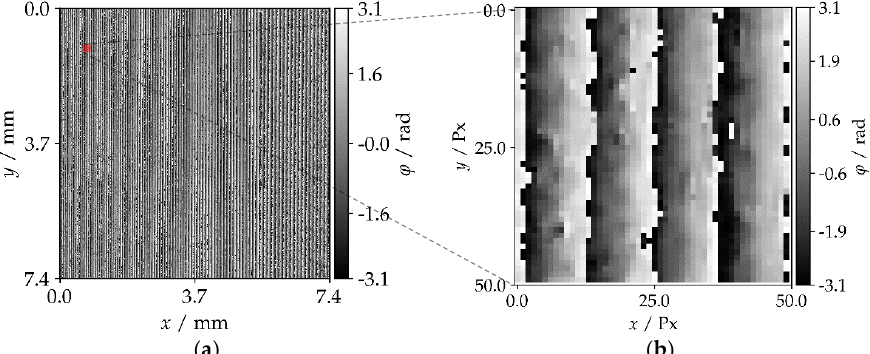
Figure 9. ( a ) All-in-focus phase map 𝜑 – the whole measurement shows sharp stripes and minimized phase noise. In the 3072 × 3072 pixels original image, the fringes are clearly resolved; ( b ) Magnified view of the red area of ( a ). The fringe spacing is 10 pixels.